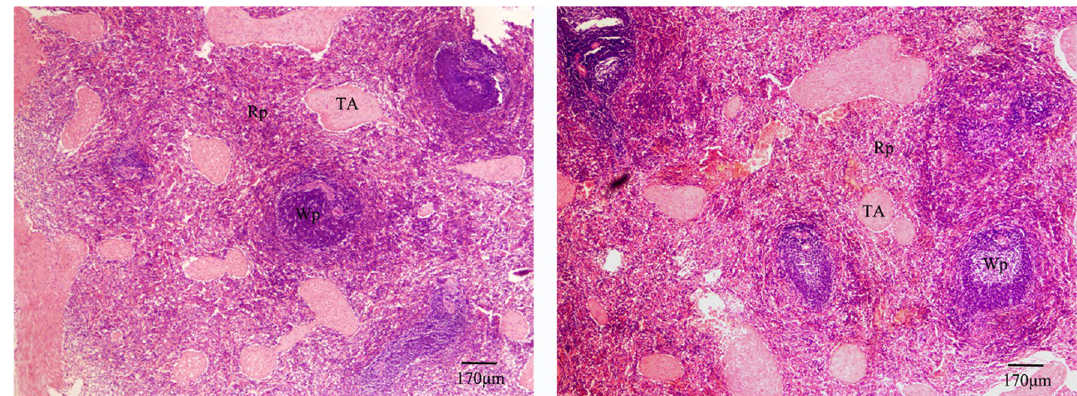
Figure 2. Representative HE-stained histology images of spleen tissue sections of Kazakh (left) and Suffolk (right) sheep under 40X magnification. The trabeculae splenicae (TA), white pulps (Wp), and red pulps (Rp) are clear and normal with no difference between these two